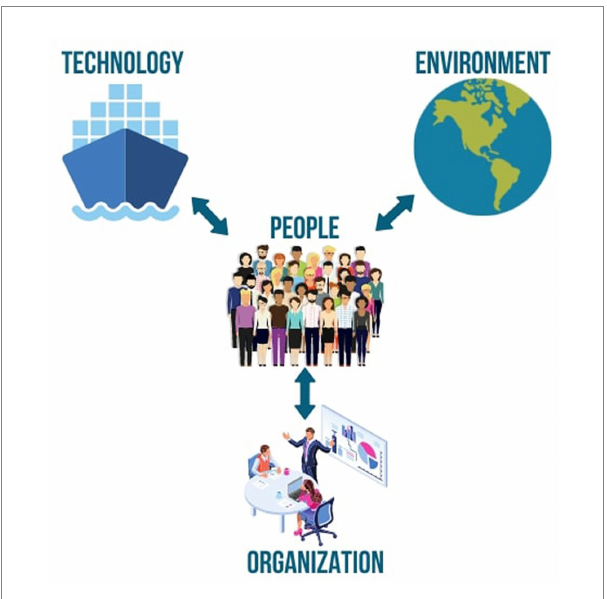
FIGURE 1 Maritime System Is a CSS [adapted from Rothblum